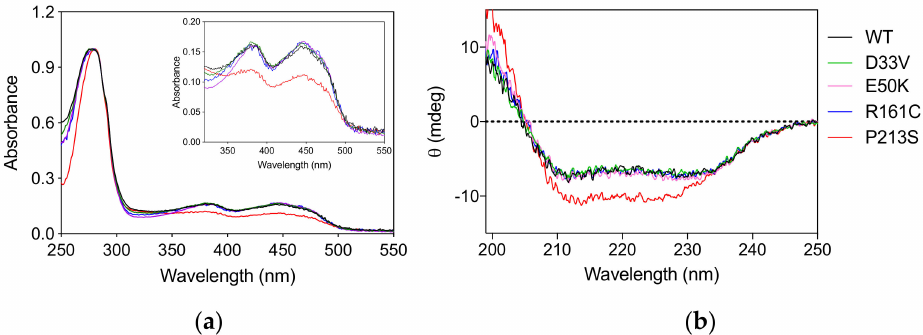
Figure 1. Spectroscopic properties of PNPO variants. ( a ) Absorption spectra of PNPO variants. The inset is an expanded view of the visible region of the same absorption spectra, showing the absorption bands due to FMN. ( b ) Far-UV CD spectra of PNPO variants. The absorption and CD spectra of the wild type enzyme are also reported as reference. All spectra were measured in 20 mM potassium-phosphate buffer, pH 7.6.